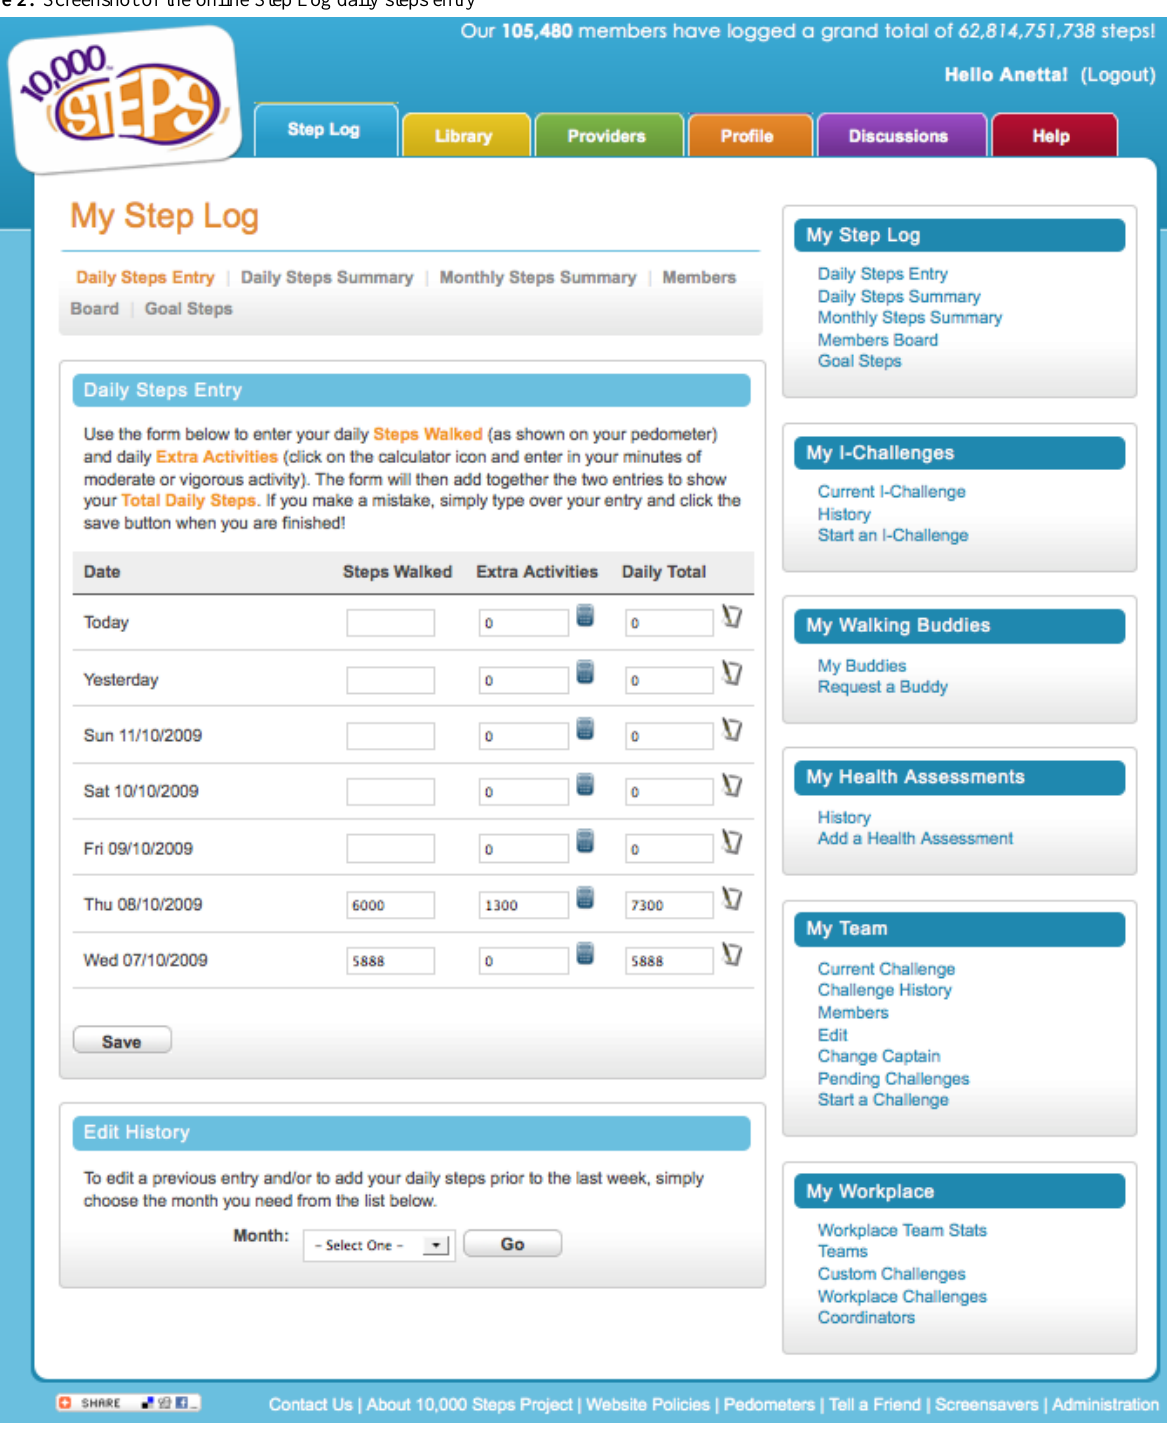
Figure 2. Screenshot of the online Step Log daily steps